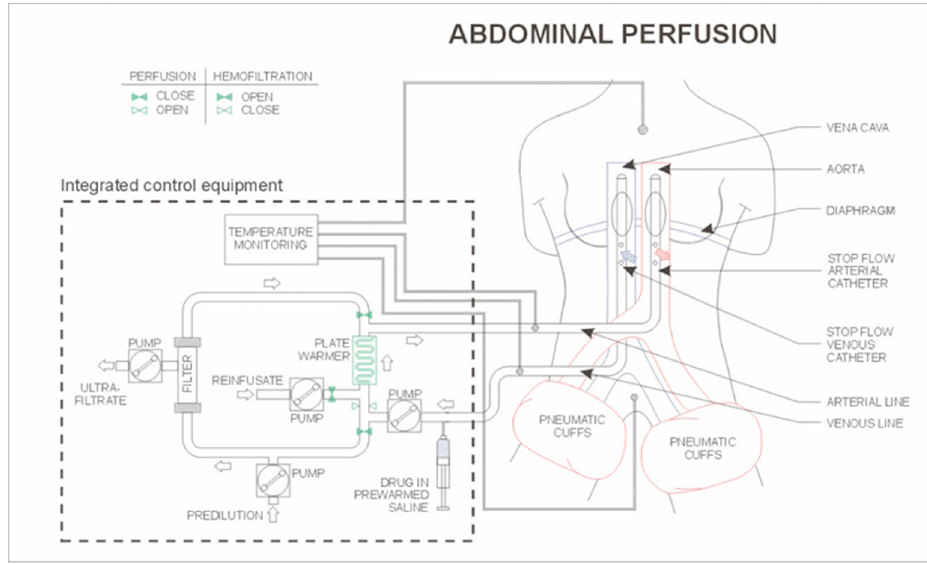
Figure 2. Schematic representation of hypoxic isolated abdominal perfusion (HAP) with chemo-